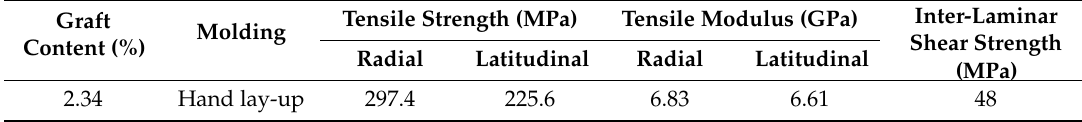
Table 3. Technical parameters of the flax fiber sheets.